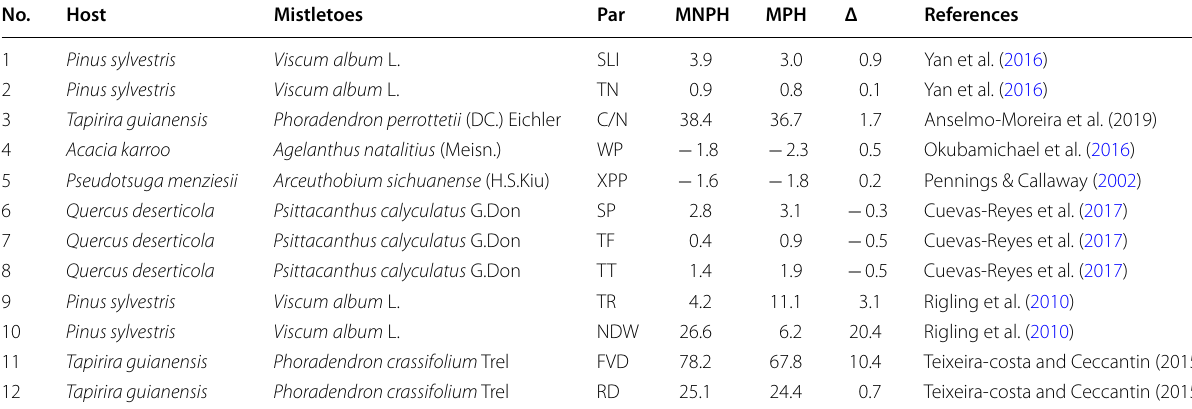
Par, parameters; Δ, change in differences in MNPH and MPH; SIL, shoot length increment (cm); TN, total nitrogen (%); C/N, carbon-to-nitrogen ratio; WP, water potential (MPa); XPP, xylem pressure potential (MPa); SP, soluble phenolics; TF, total flavonoids; TT, total tannins; TR, tree rings (count); NDW, needle dry weight (g); FVD, function vessel diameter (µm); RD, rays diameter (rays/mm 2 )